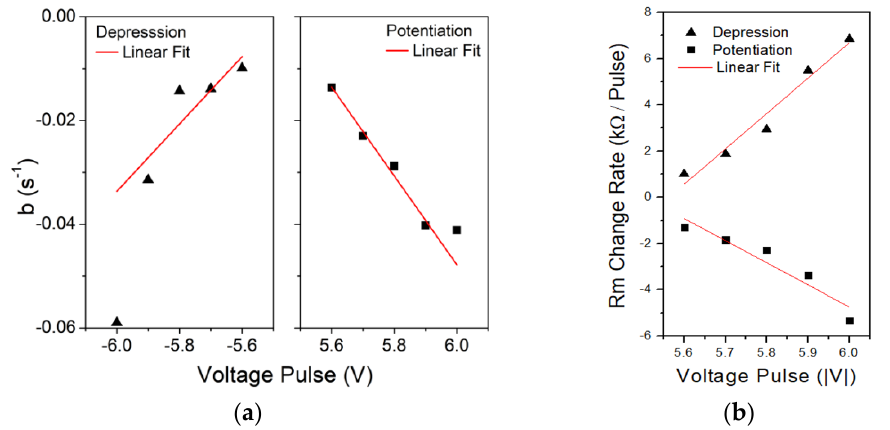
Figure 5. ( a ) Linear dependence of the exponent b . The values of b were extracted from fitting of relation (2) to experimental data as shown in Figure 4. ( b ) Average rate of R m change for different potentiation/depression pulse amplitudes.